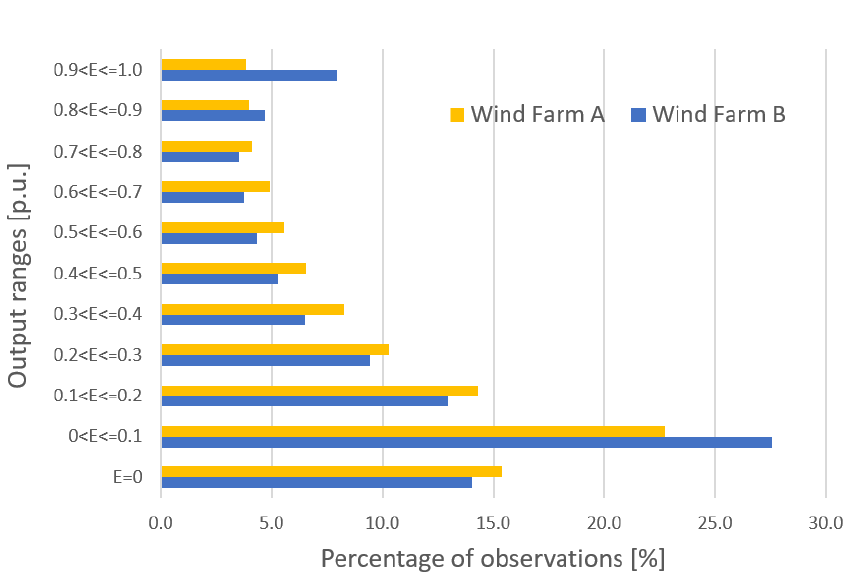
Figure 1. Percentage of time-series observations in particular generation ranges.